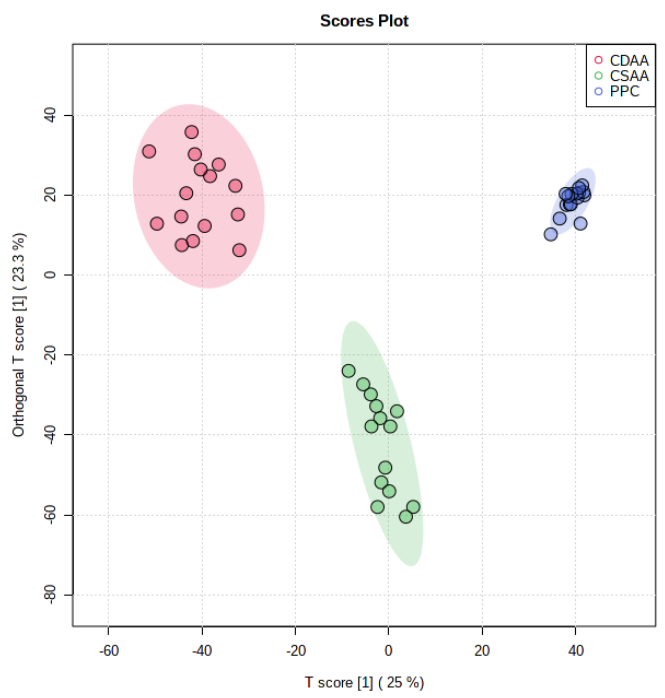
Figure 5. Orthogonal partial least squares discriminant analysis (OPLS-DA) cross-validated classification plot. The OPLS-DA analysis of the groups shows R2X = 0.25, RXY = 0.879, and Q2 = 0.865. Table 2. Fold changes of the serum lipid species in the C57BL/6 mice after being fed a CDAA